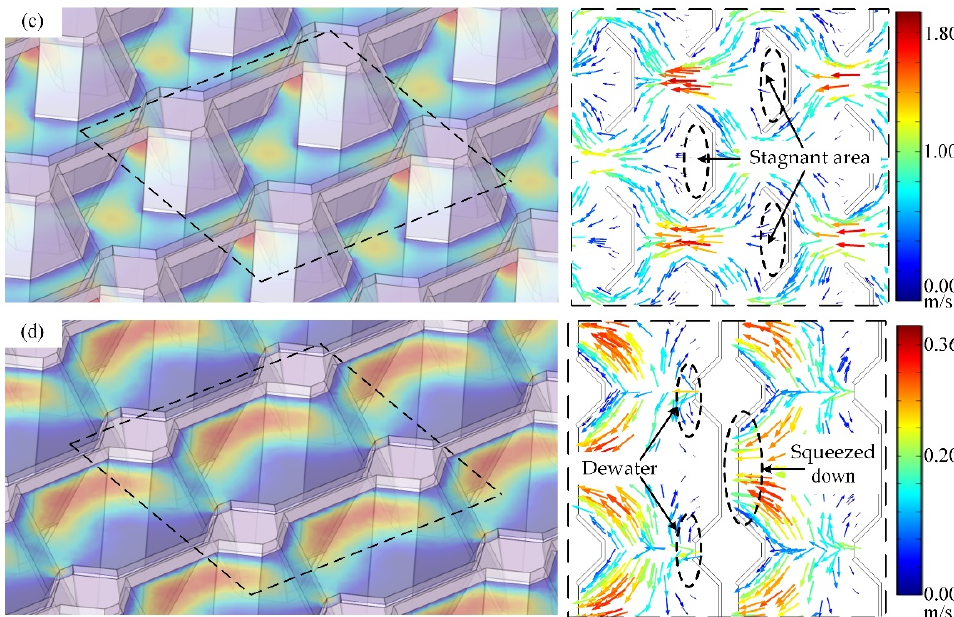
Figure 4. Three layers of cathode 3D bionic flow field with gas velocity nephogram and streamlines: ( a ) overview of three regions, ( b ) bottom diffusion region, ( c ) middle turbulence region, and ( d ) top dewatering region.